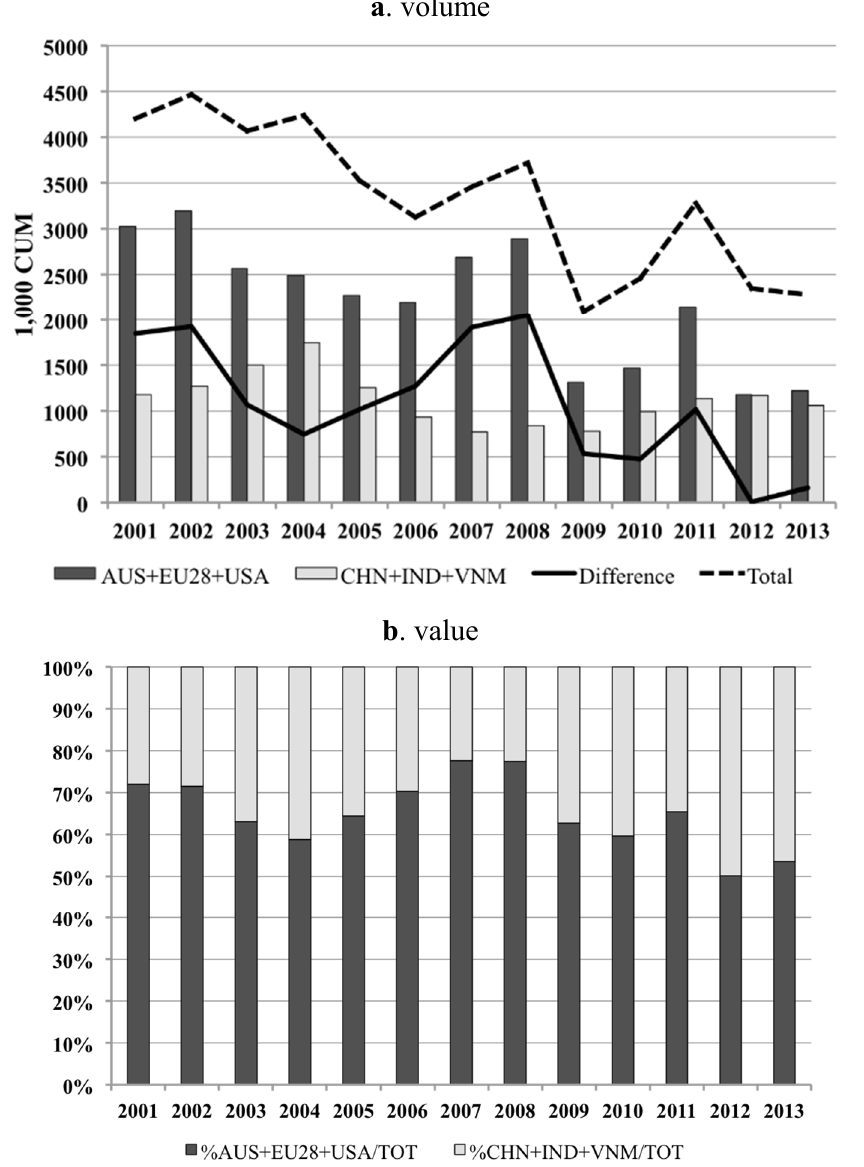
Figure B2. ( a ) Tropical timber product imports by groups of selected countries from VPA countries, in volume; and ( b ) % incidence of selected countries on total imports (2001–2013). AUS = Australia; CHN = China; EU-28 = European Union; IND = India; USA = United States of America; VNM = Vietnam. Difference means difference between (AUS + EU-28 + USA) and (CHN + IND + VNM). Source: own elaboration from